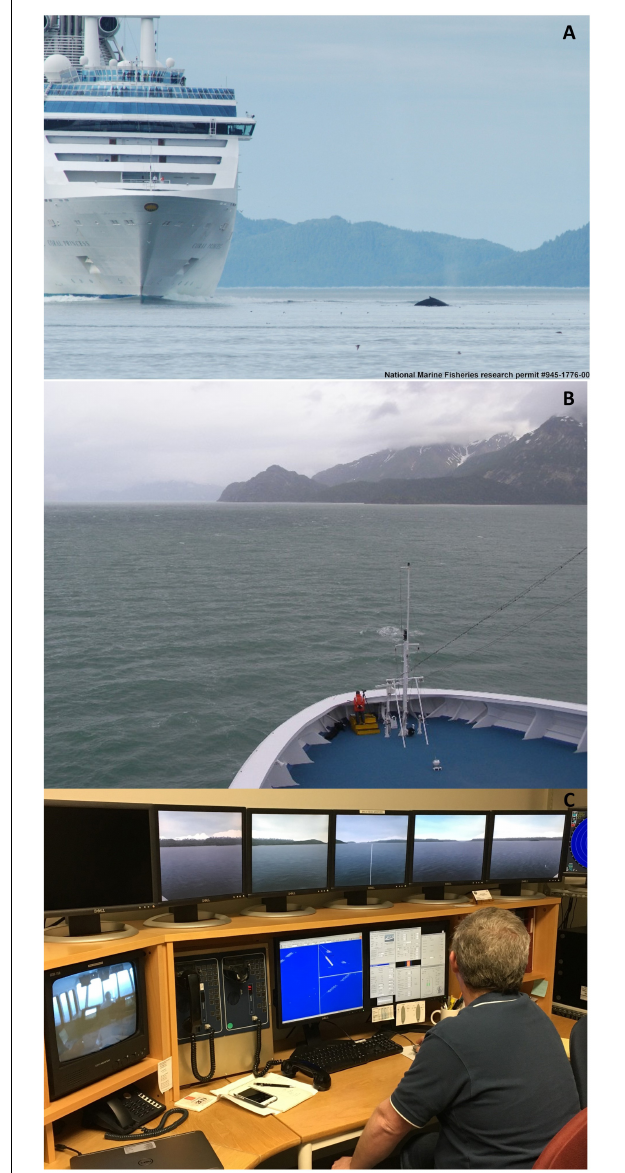
FIGURE 2 | (A) A humpback whale surfaces in front of a large cruise ship, Glacier Bay, Alaska. (B) An observer standing at the bow of a large cruise ship in Alaska quantifying the frequency, proximity, and behavior of humpback whales that surface forward of the ship. The Observer program has occurred since 2006 and included more than 750 cruises. (C) The command center at the AVTEC Full Mission Bridge simulator in Seward, Alaska, during simulations whereby marine pilots simulated whale encounters and active whale avoidance. Closed-circuit video of 2 pilots in the bridge room can be seen in lower left of the photo enacting a whale avoidance